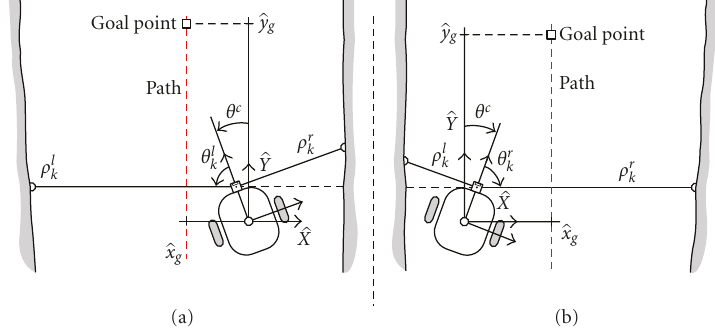
= − 90 ◦ , or (b) θ l = 90 ◦ . k k